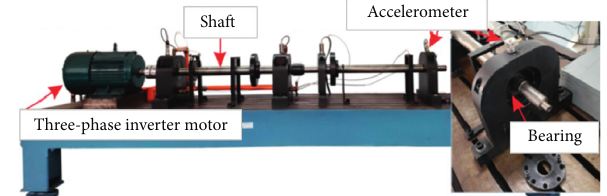
Figure 12: The test bench of the